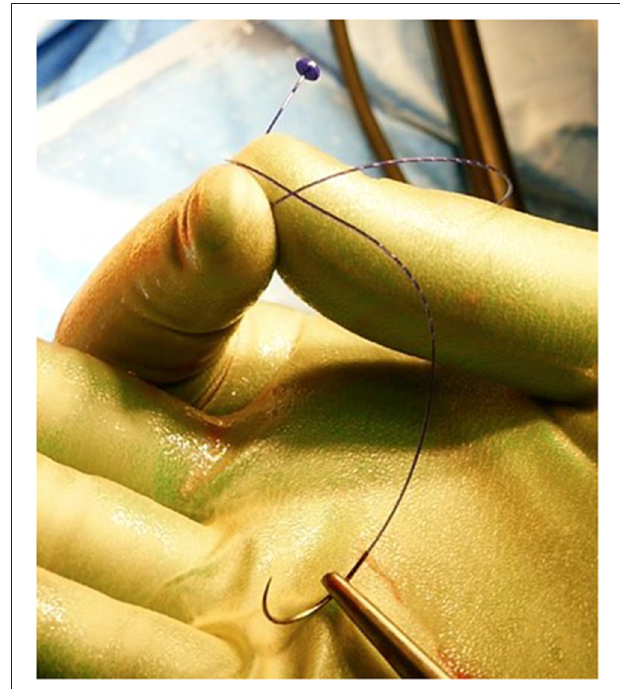
FIGURE 1 | Filbloc